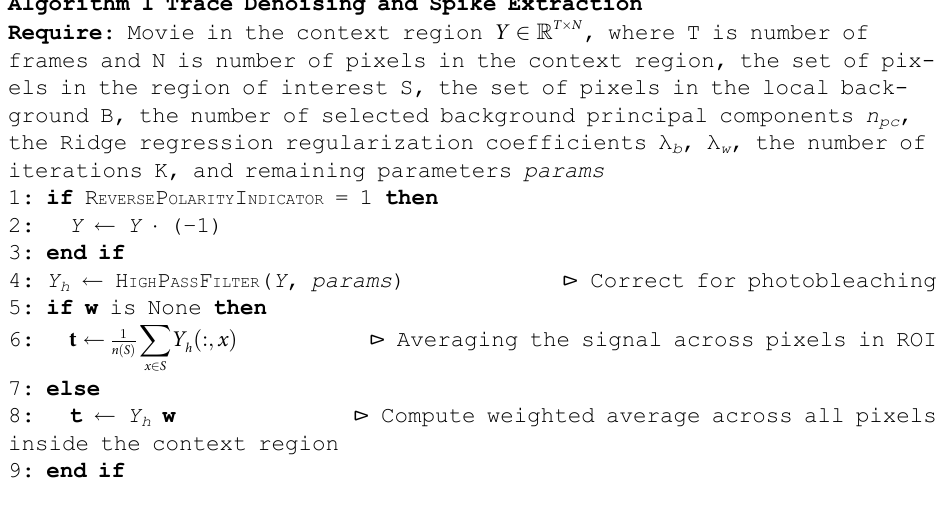
Algorithm 1 Trace Denoising and Spike